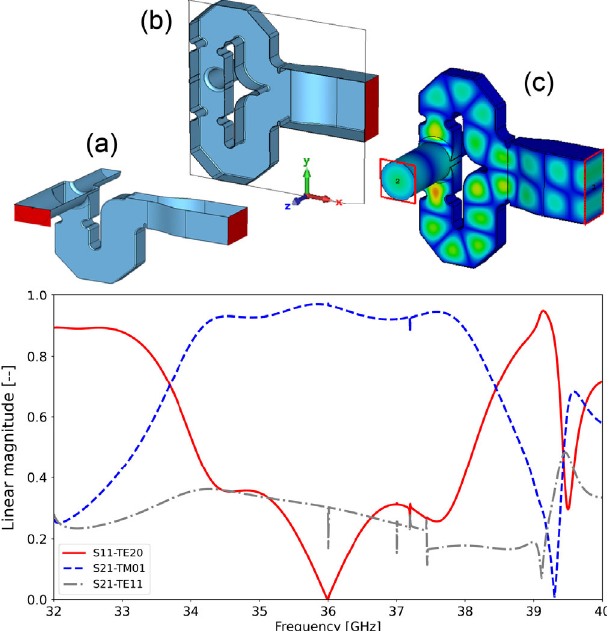
FIG. 16. TE20 to TM01 mode converter ’ s horizontal (a) and vertical (b) cross sections, field pattern distribution (c), and its matched S-parameters (bottom).